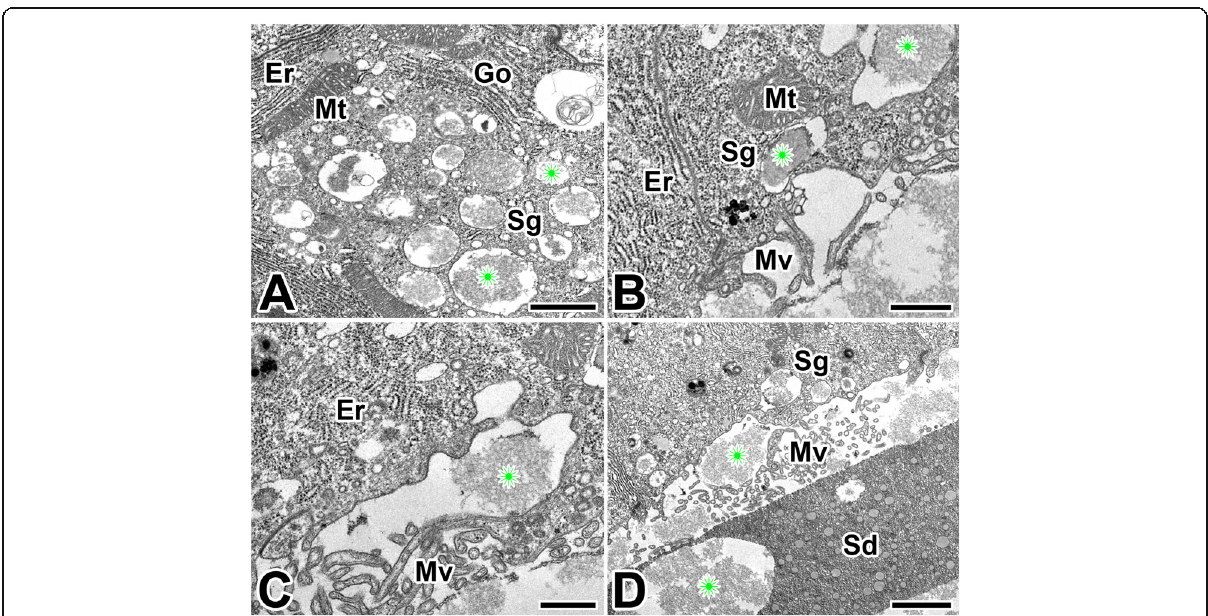
Fig. 9 Transmission electron micrographs of the anterior region of the silk gland in the caddisworm H. nigrovittatus. Secretory granules (Sg) are electron-lucent spherical granules with fine fibrous materials (asterisks). At the vicinity of secretory granules well developed rough ER (Er), Golgi apparatus (Go), and mitochondria (Mt) are seen. D: Secretory granules are released to the lumen via the microvilli (Mv) by the merocrine secretion. Gradual transition of the secretory materials (asterisks) from cell to lumen are clearly seen. All scale bar indicates 0.5 μ m